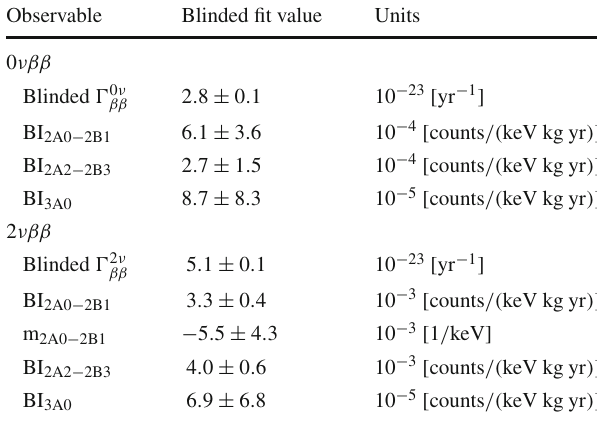
Table 4 Results of the blinded fit to 0 νββ (top) and 2 νββ (bottom) candidate events in the signatures of Table 3. For each parameter the mean and standard deviation of the corresponding marginalized poste- rior distribution are reported. These values are used only as input to the sensitivity studies and fit validation. Final results reported in Table